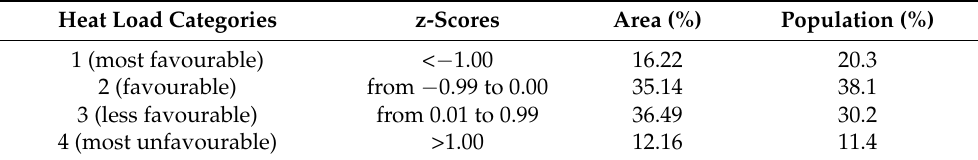
Table 3. Thermal load of urban areas.